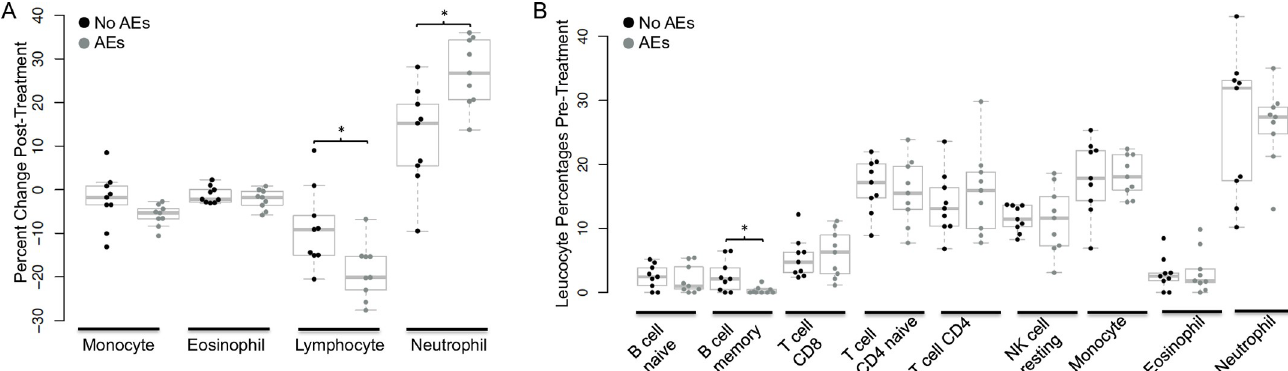
Fig 5. Estimated leucocyte subtypes (CIBERSORT) for the two adverse events (AEs) groups. Fig 5A: Percent change post-treatment of leukocyte subtypes. Estimated lymphocytes decreased more and estimated neutrophils increased more post-treatment in individuals with moderate AEs (n = 9) compared to individuals with no AEs (n = 9). B: Estimated leukocyte proportions pre-treatment. Individuals that did not develop AEs (n = 9) had higher levels of estimated memory B cells pre-treatment compared to individuals that developed moderate AEs (n = 9). � P < 0.05 by Mann-Whitney U tests.